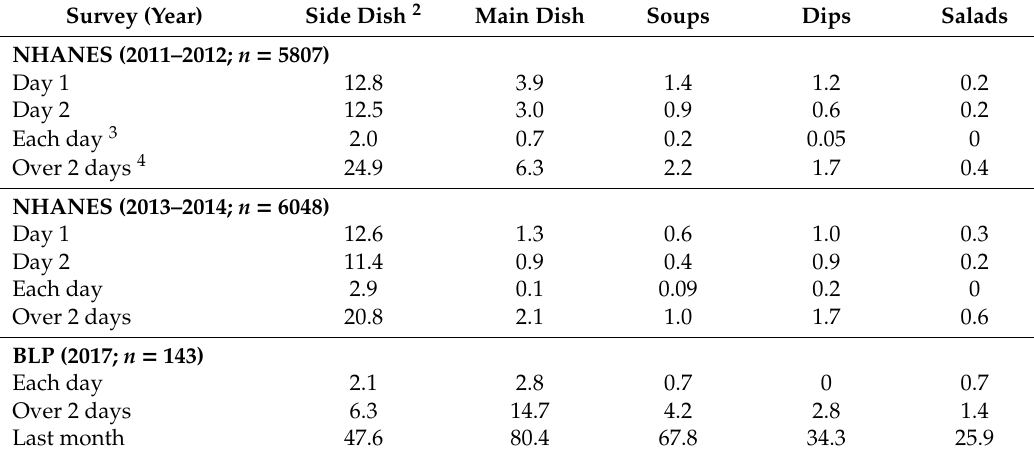
Table 3. Consumption frequency of legume-containing dish types in US adults: National Health and Nutrition Examination Survey (NHANES) and Beans, Lentils, Peas Nutrition Education Online Parent Survey (BLP) 1